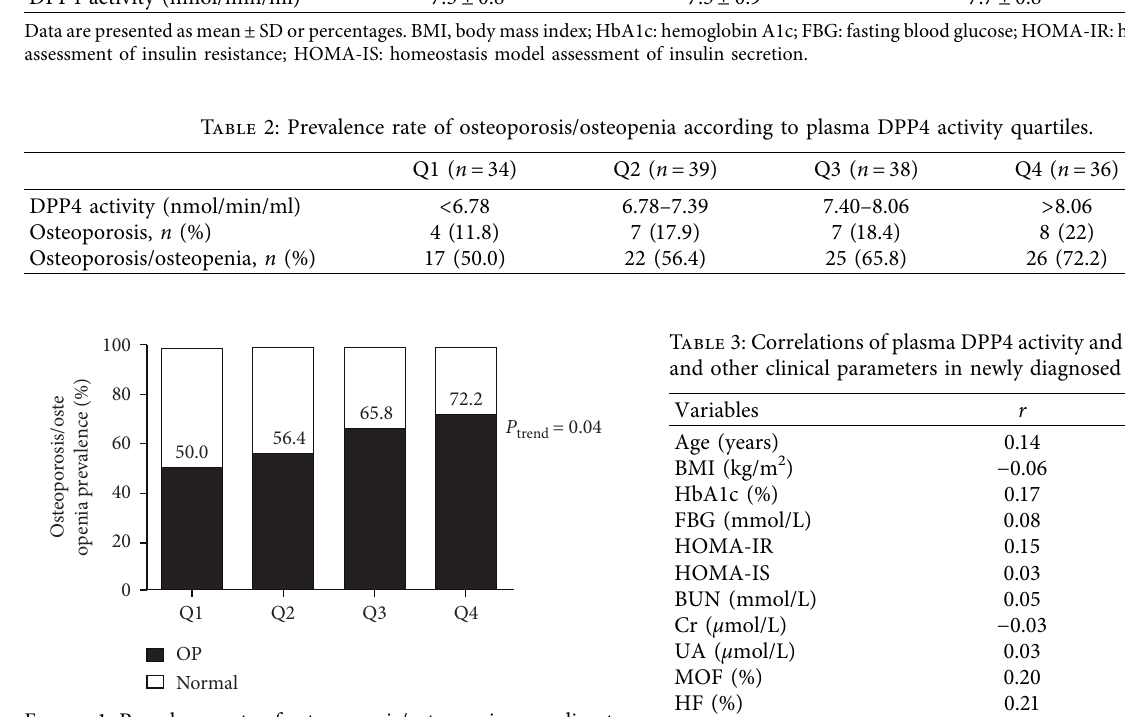
Figure 1: Prevalence rate of osteoporosis/osteopenia according to plasma DPP4 activity quartiles. Q1: < 6.78 (nmol/min/ml), Q2: 6.78–7.39 (nmol/min/ml), Q3: 7.40–8.06 (nmol/min/ml), and Q4: > 8.06 (nmol/min/ml). Normal, normal bone mineral density ( T - score ≥ − 1); OP, osteoporosis/osteopenia ( T -score < − 1) (linear-by- linear association for the trend test).